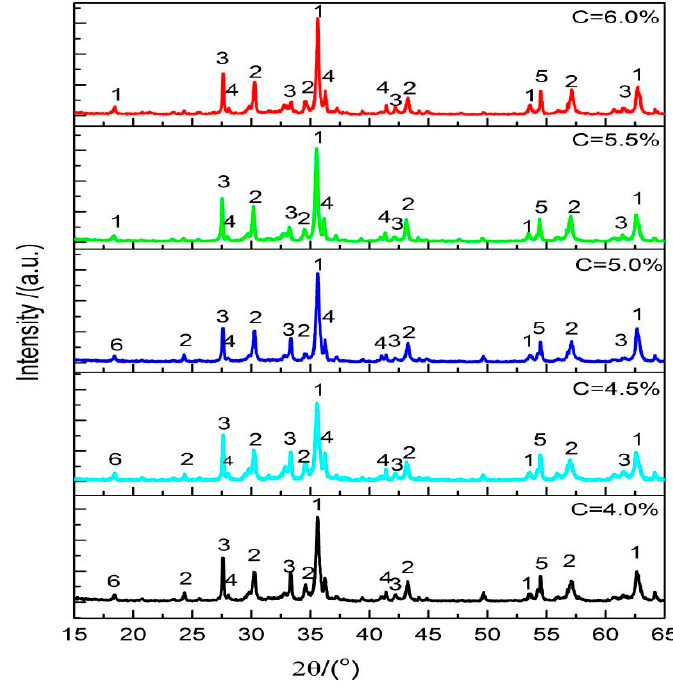
Figure 5. XRD of HCVTS at different coke ratios: 1: magnetite; 2: hematite; 3: calcium ferrite; 4: perovskite; 5: silicate; 6: